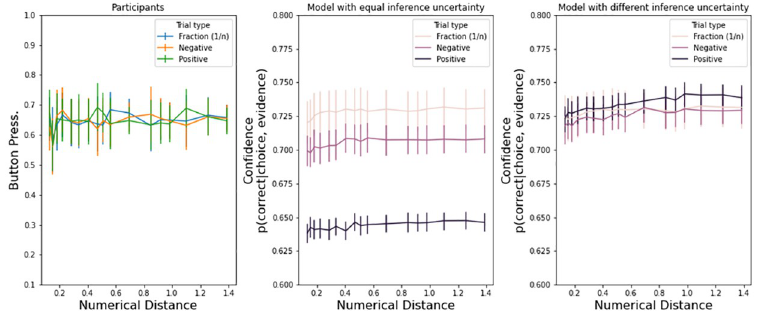
Fig 13. Reduced uncertainty in trials with positive numerals. Exp. 3 (bottom panels): models with equal uncertainty had an UN = 4.5 for all types of numerals. Models with different uncertainty had UN pos = 2.5, UN neg = 4, UN frac = 4.5. Error bars are